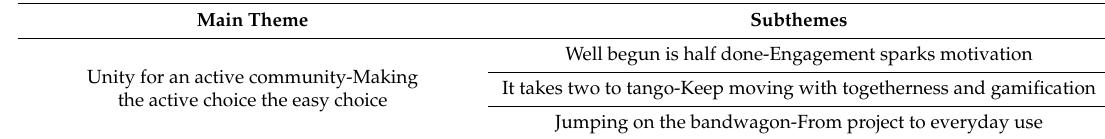
Table 1. Overview of the